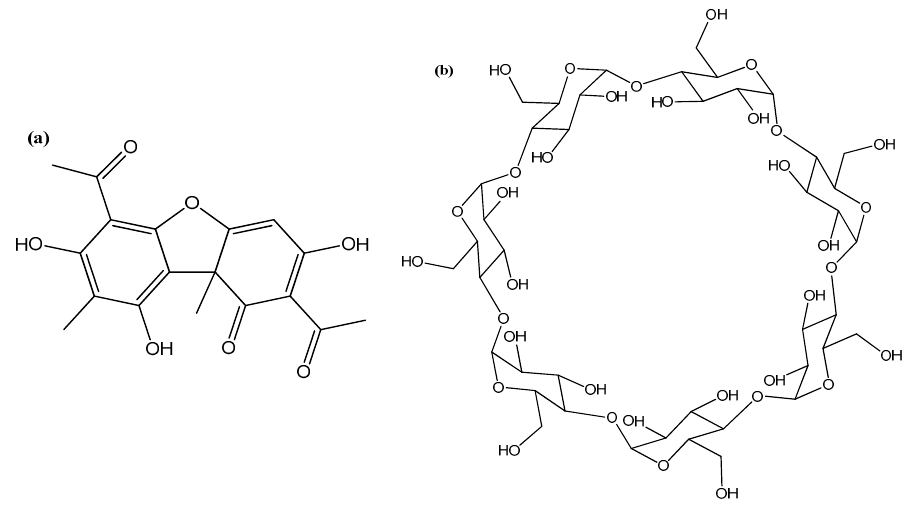
Figure 10. Chemical structure of ( a ) usnic acid and ( b ) β -cyclodextrine.